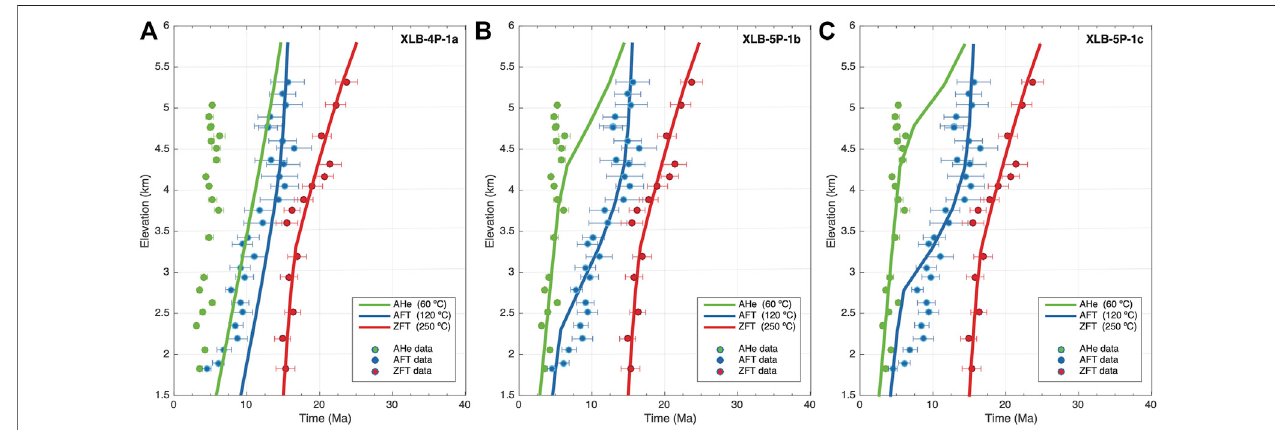
FIGURE 9 | Model results for exhumation histories shown in Figure 8 and Table 1 . (A) simple 4-stage exhumation history satis fi es age-elevation data with apparent ages older than ∼ 15 Ma. (B) 5-stage exhumation history with 2-stage exhumation since 15 Ma. (C) 5-stage exhumation history similar to panel (B) , with slight modi fi cations to rates during each of the post-15 Ma exhumation